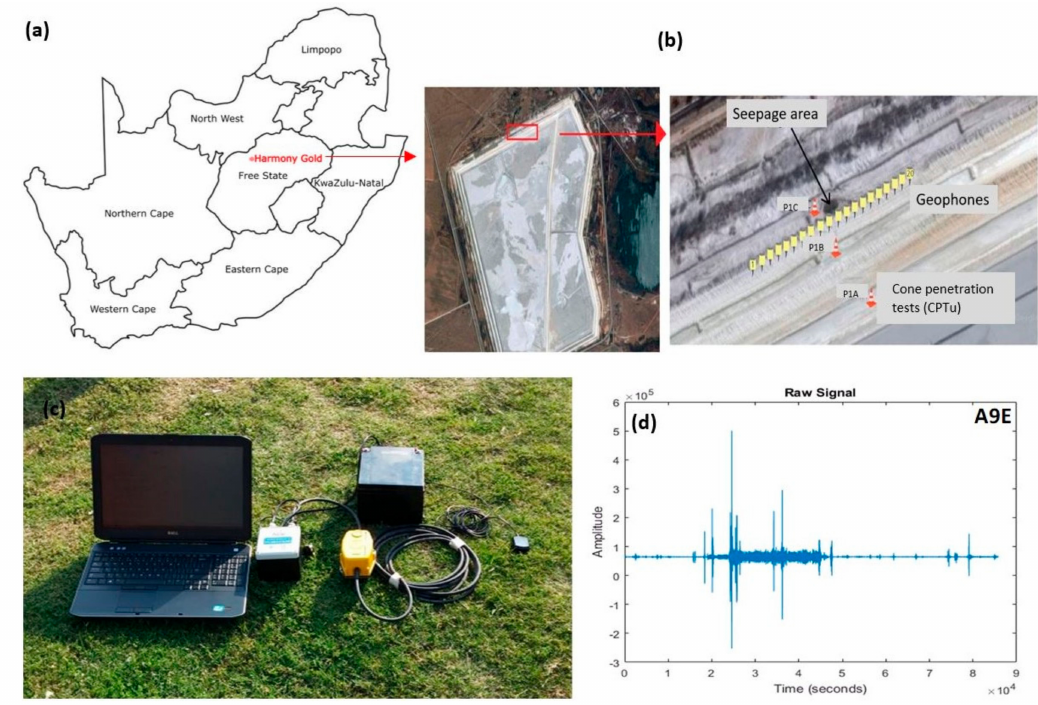
Figure 12. Passive seismic study of a mine tailing dam stability: ( a ) Location map of Harmony Gold; ( b ) aerial views showing the surveyed portion of the wall (red box) and the geophones positioned near an area where a seepage was detected; ( c ) instrumentation used to record the ambient noise; and ( d ) example of raw signal from one of these recording